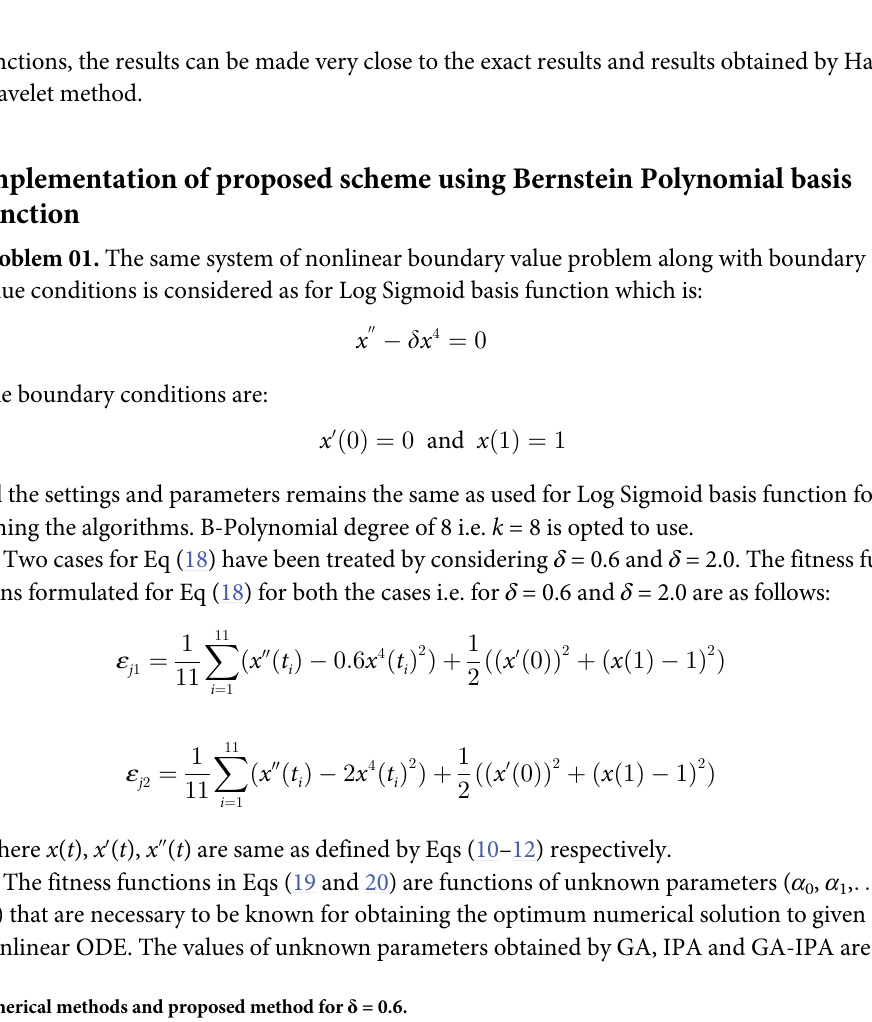
Table 7. Comparison of absolute errors between numerical methods and proposed method for δ = 0.6. Numerical Methods [x Exact